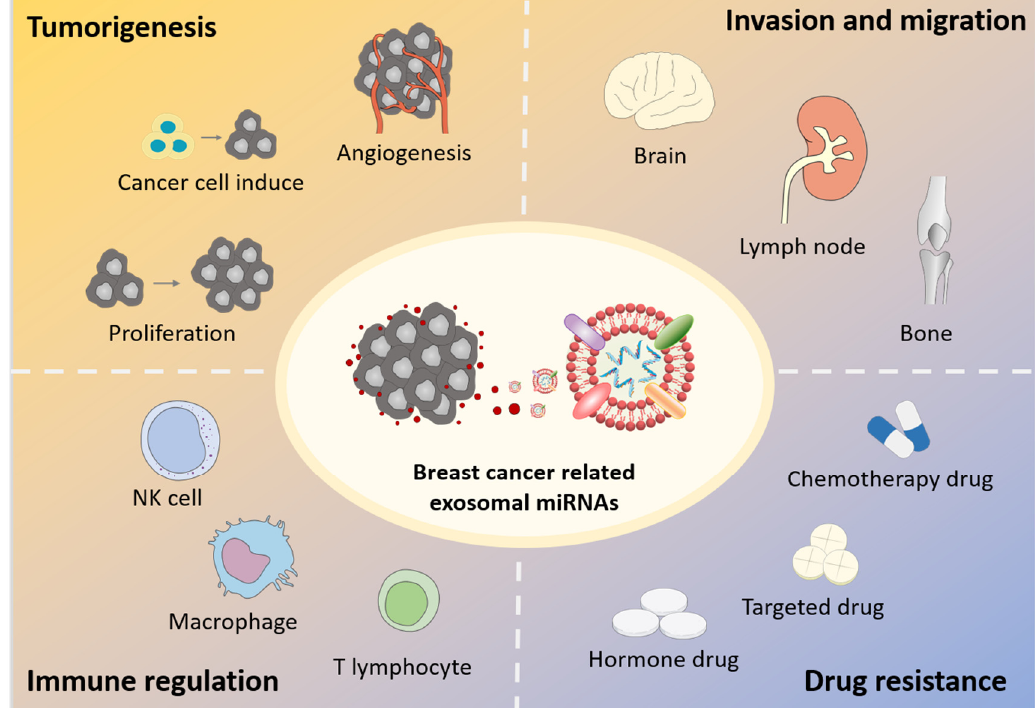
Figure 1. Breast cancer ‐ related exosomal miRNAs in breast cancer progression.